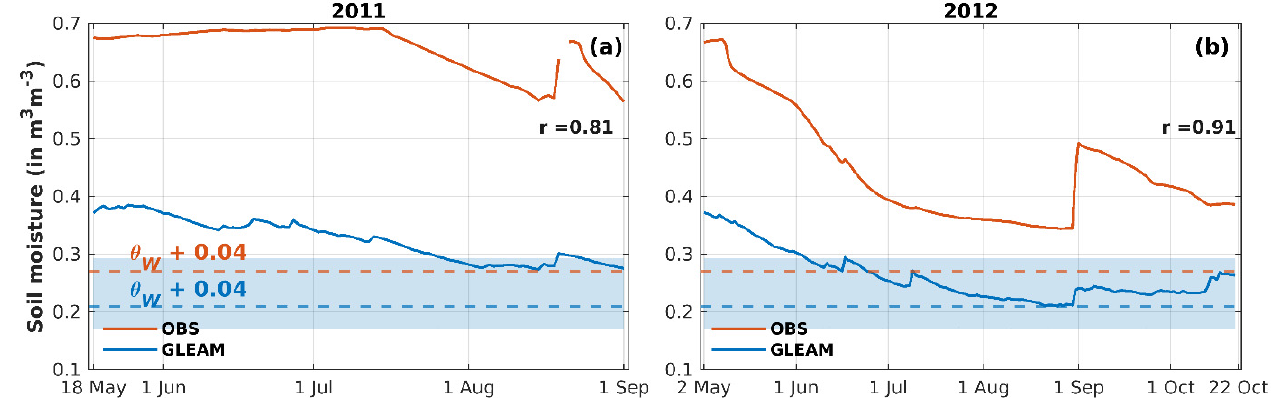
Figure 2. Time series of the volumetric soil moisture (in m 3 m − 3 ) at the MOFLUX site as obtained from measurements at 100 cm (orange) and as estimated by the GLEAM model at the root-zone level at the 0.25 ◦ × 0.25 ◦ grid cell including the site (blue) in ( a ) 2011 and ( b ) 2012. The dashed horizontal lines mark the threshold values ( θ 1 = θ W + 0.04) for each dataset. The blue shading indicates the transition between the GLEAM wilting point and the threshold value ( θ W + 0.12) obtained by model optimization against isoprene MOFLUX data.